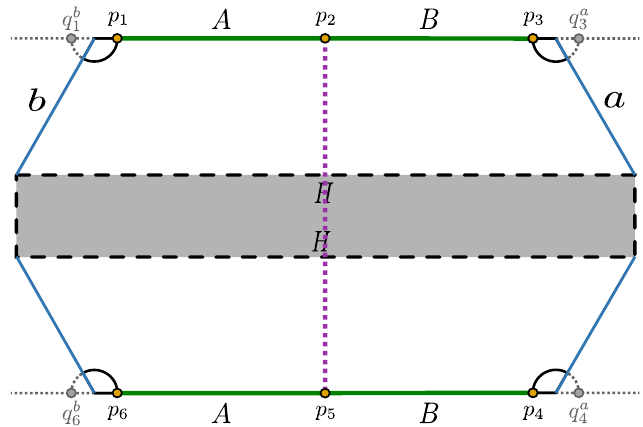
Figure 5 . Possible channel for S R . The violet dotted line defines the EWCS. Here q b q b = r I − (cid:15) are the mirror images of the points p 1 = r I + (cid:15) and p 6 = r I + (cid:15) respectively with respect to 6 the b -boundary. Similarly, q a = r O + (cid:15) and q a = r O + (cid:15) are the mirror images of the points p 3 = r O − (cid:15) 3 4 and p 4 = r O − (cid:15) respectively with respect to the a -boundary. The point p 2 and p 5 are equal to r